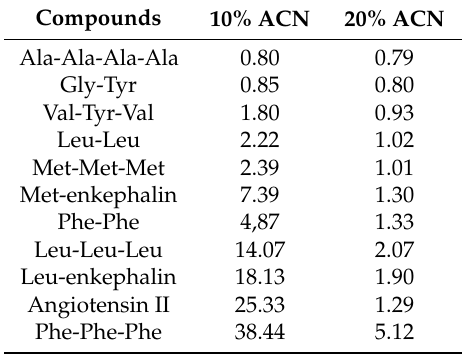
Table 1. Retention times (min) of oligopeptides eluted on Hypersil Gold aQ (50 mm × 1 mm, 40 ◦ C) with 10/90 ACN/H 2 O and 20/80 ACN/H 2 O as the mobile phase.